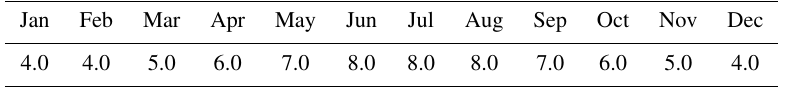
Table 1. Midmonthly |∇ θ e | threshold values in kelvin per 100km to compute the thermal component of frontal areas, as described in Sect. 2.3.